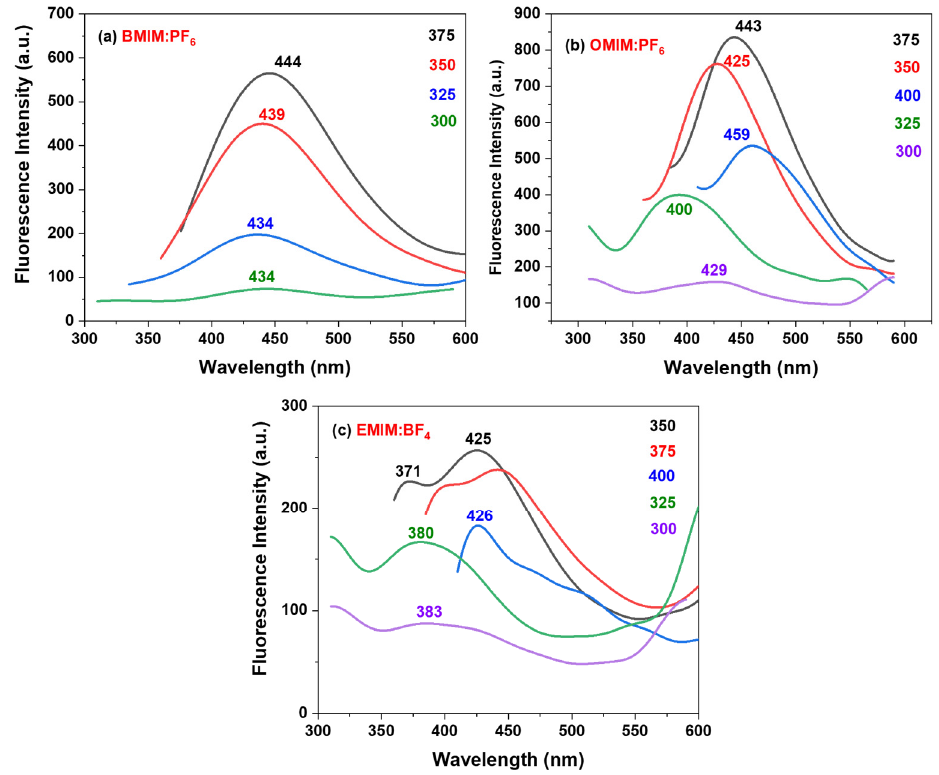
Figure 7. Fluorescence spectra of the selected ILs deposited on the surface of NPAS excited between